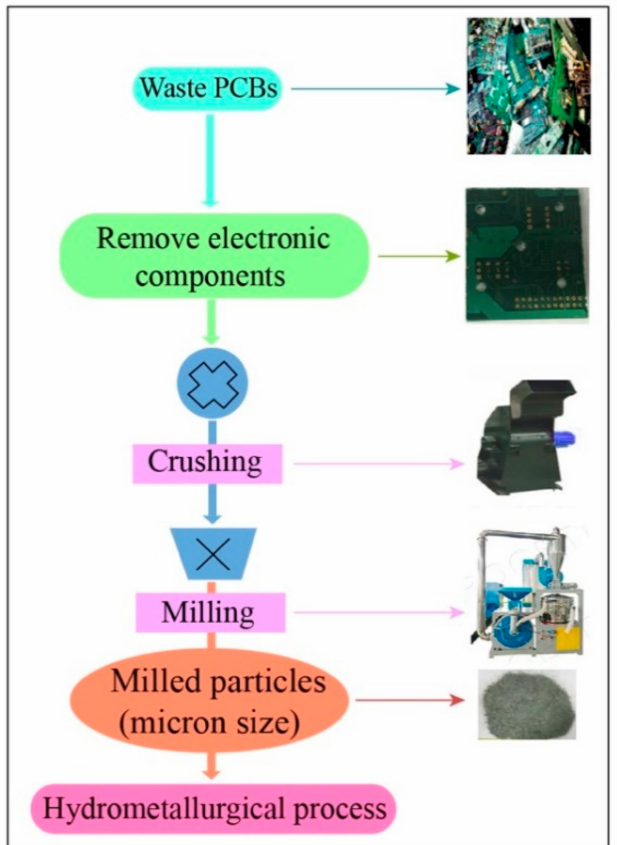
Figure 8. Conventional PCB pre-treatment flowsheet for hydrometallurgical e-waste recycling